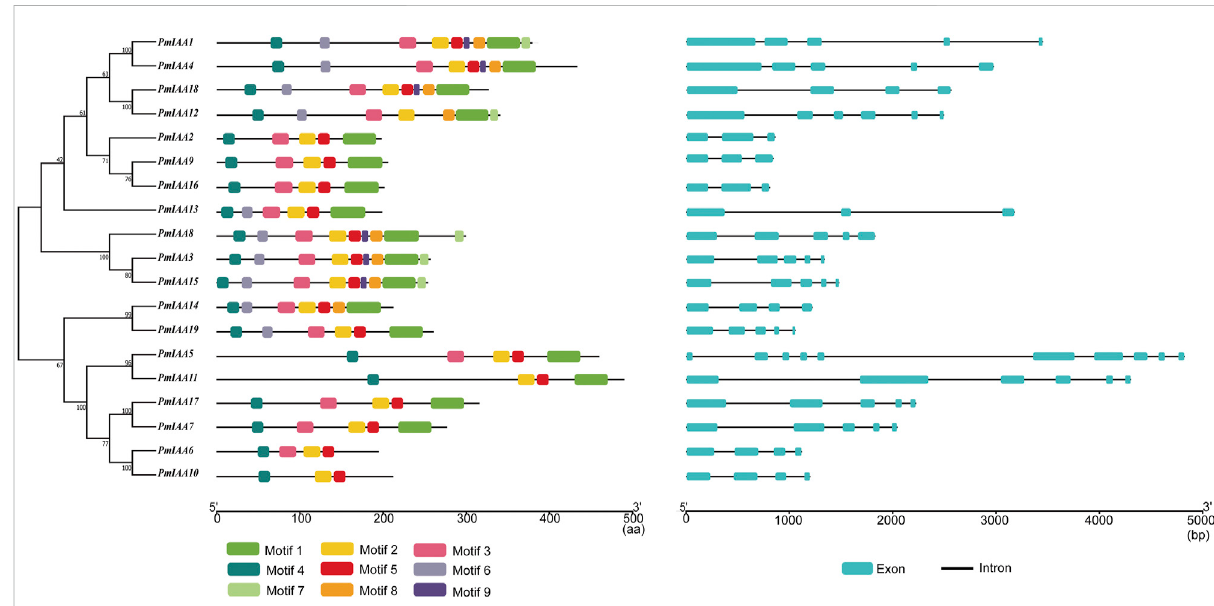
FIGURE 3 The phylogenetic relationship, protein motif, and gene structure analysis of PmIAAs in mei. The ML tree on the left includes 19 PmIAA proteins. The schematic in the middle represents different protein motifs identi fi ed using MEME. The gene structure of PmIAAs was displayed on the right.